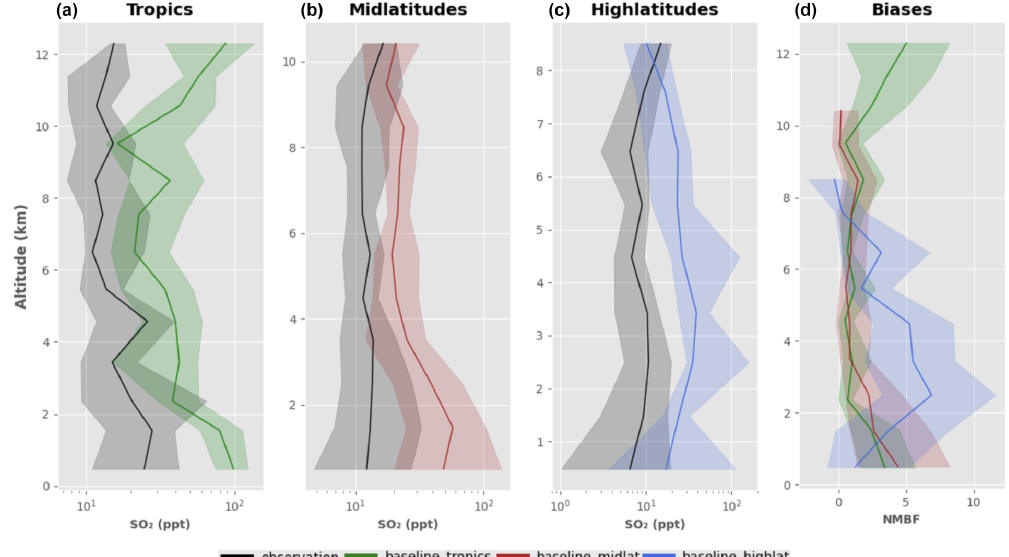
Figure 4. The first three columns show the vertical profile of the SO 2 (at STP) as observed (ATom4, April–May 2018) and the simulated data from the baseline (bug-fixed) configuration of UKESM in the tropics (25 ◦ N–25 ◦ S), mid latitudes (25–60 ◦ N and 25–60 ◦ S) and high latitudes (60–90 ◦ N and 60–90 ◦ S). The fourth column shows the NMBF of the baseline simulation in the tropics, mid latitudes and high latitudes. The bold line represents the median and the shaded region represents the corresponding interquartile range (25th and 75th percentiles) in a 1km altitude